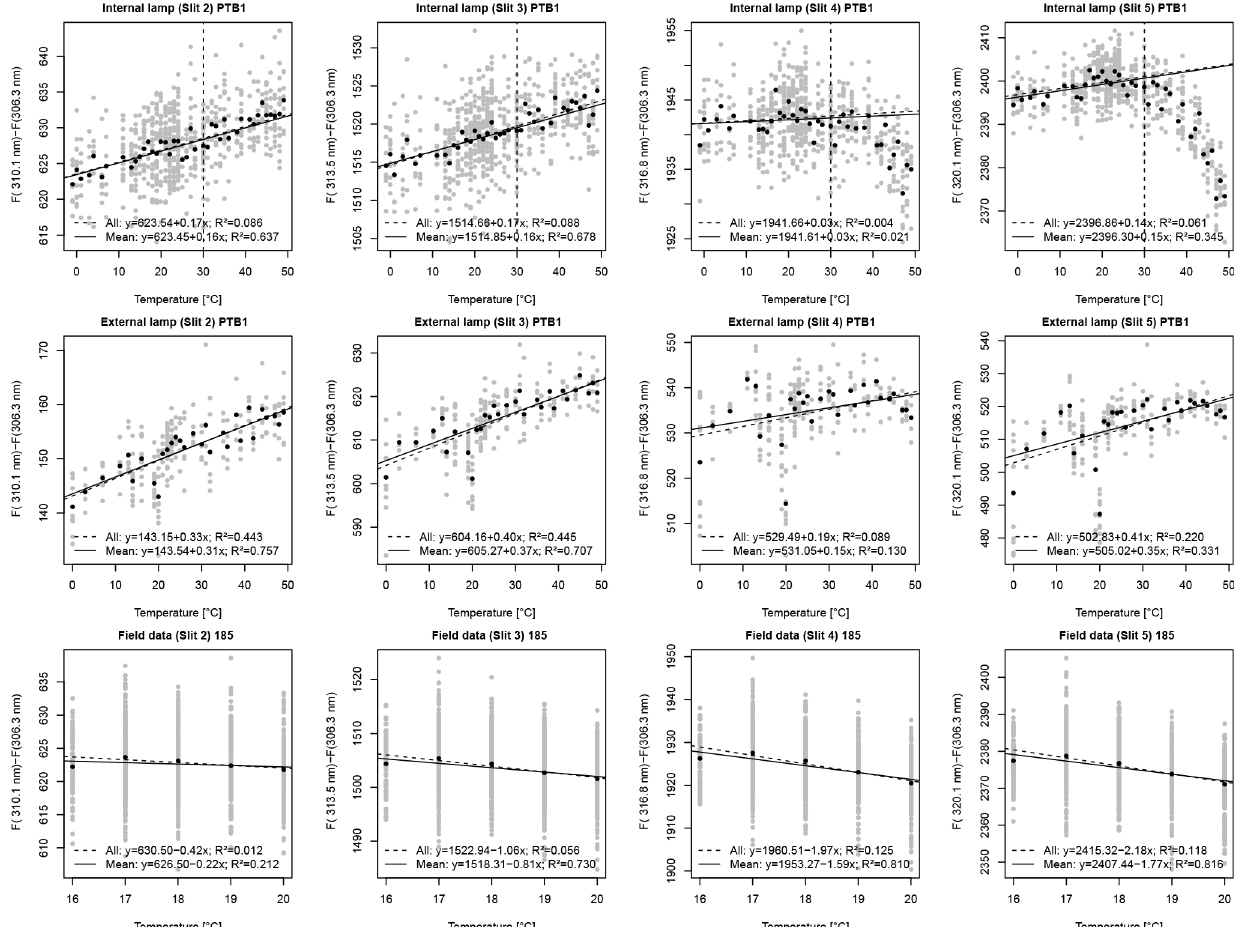
Figure 7. PTB1 experiment. Linear regressions between relative Brewer data (slits 2, 3, 4 and 5 relative to slit 1) and temperature. Coefficients are determined from internal and external lamp measurements in the temperature chamber and from field data. Linear regression using individual measurements (grey points) is represented by dashed lines, while solid lines represent the linear regression when using average values at each